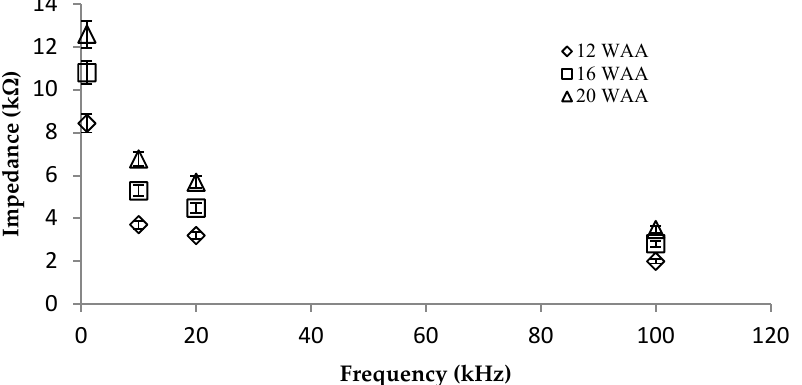
Figure 3. The impedance measurements of oil palm fruitlet samples at different maturity stages and different frequencies.